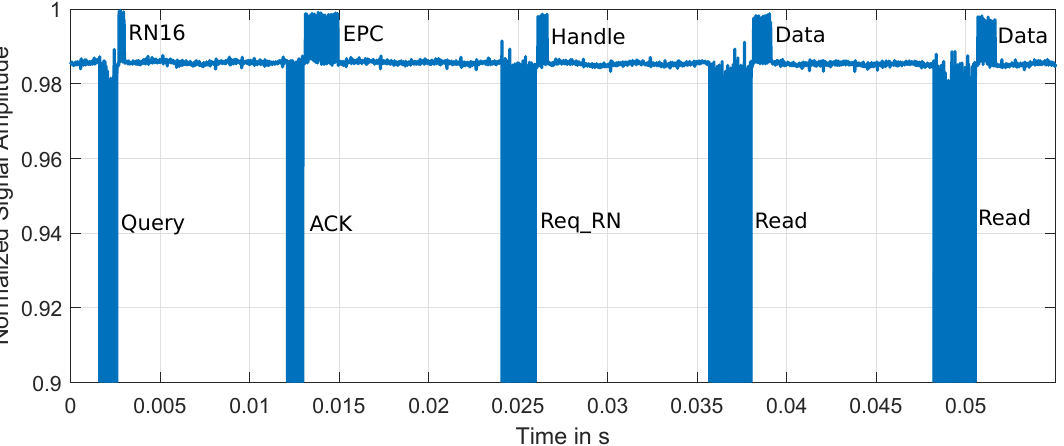
Figure 9. Three consecutive Read commands and three Wireless Identification and Sensing Platform (WISP) accelerometer tag